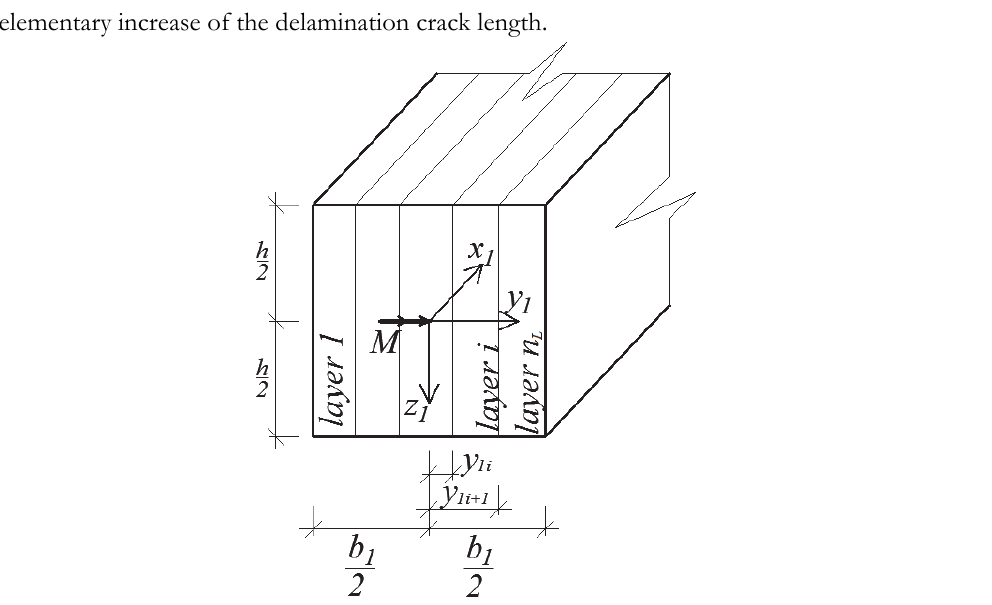
Figure 2: Cross-section of the left-hand crack arm in the beam